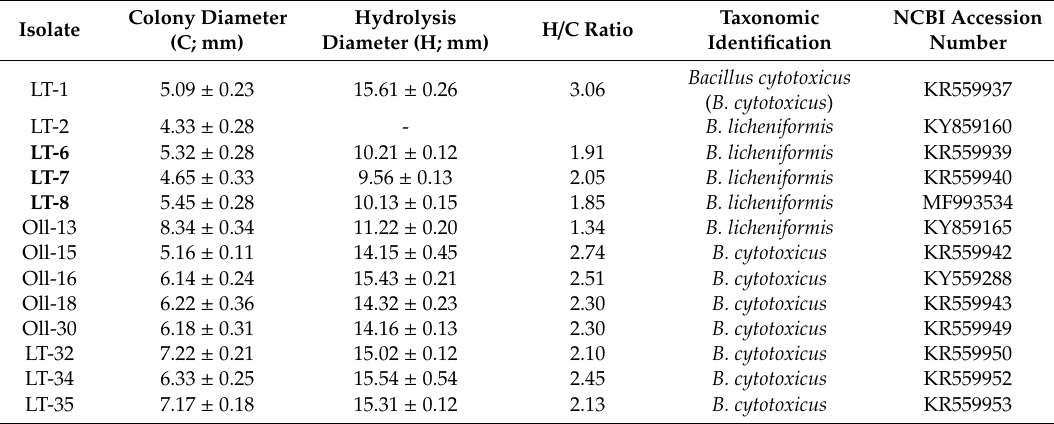
Table 1. Characteristics of the proteolytic Bacillus isolated from Domuyo. All the isolates developed proteolytic activity at 50 ◦ C after 24 h, except for LT-6, LT-7, and LT-8 (in bold) that did it after 48 h. Colony Diameter Isolate (C;